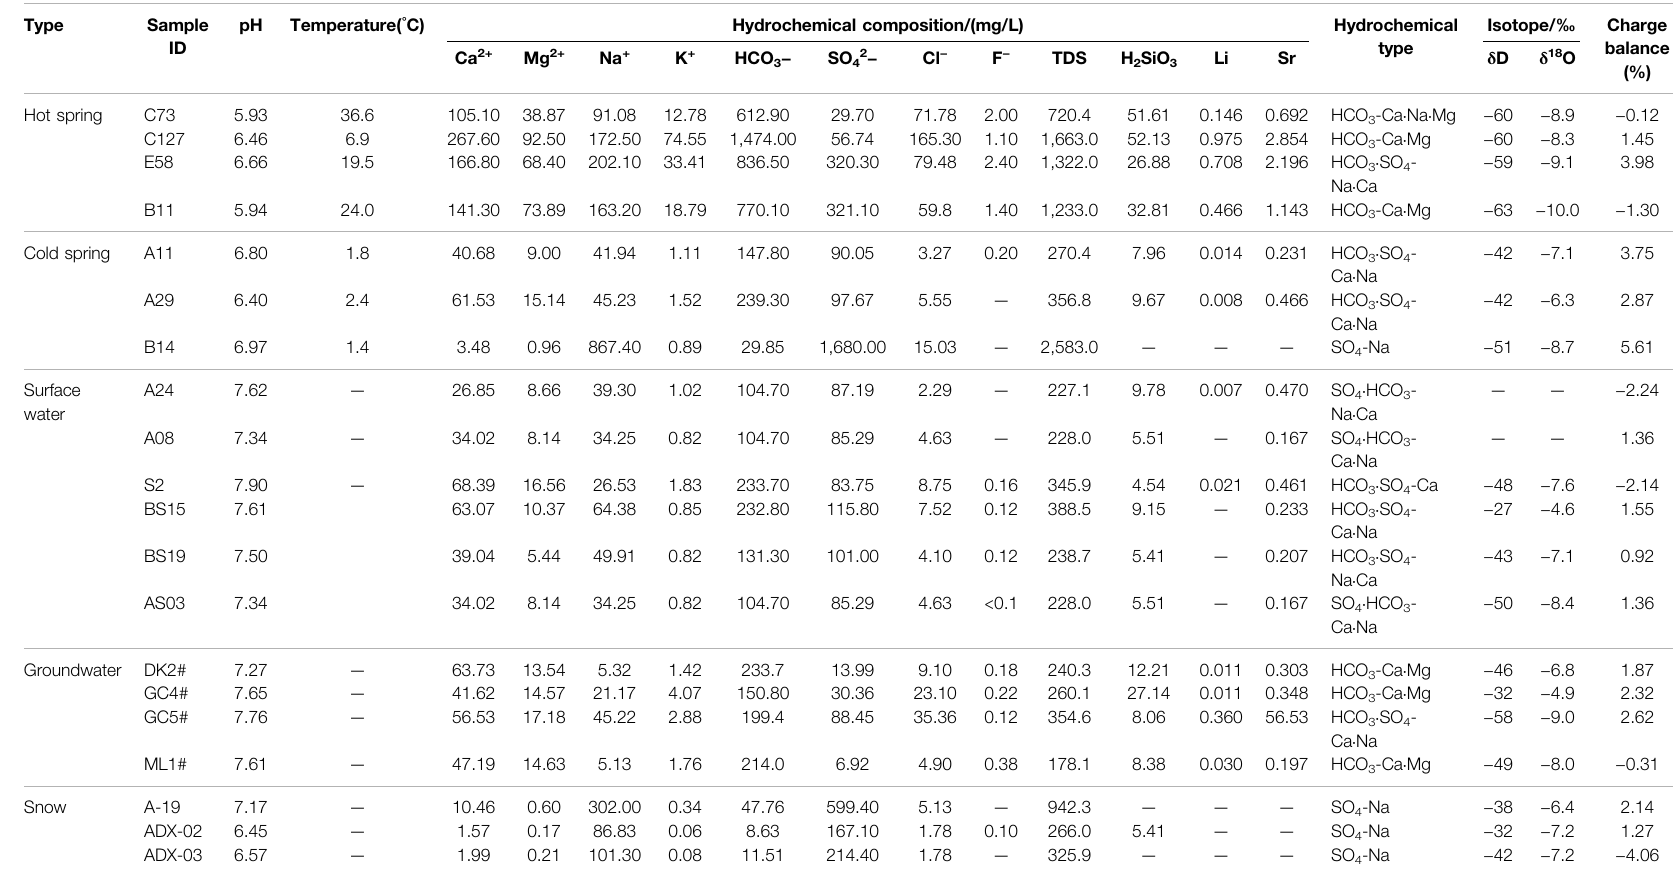
TABLE 1 | Chemical composition and hydrogen and oxygen isotope composition of water